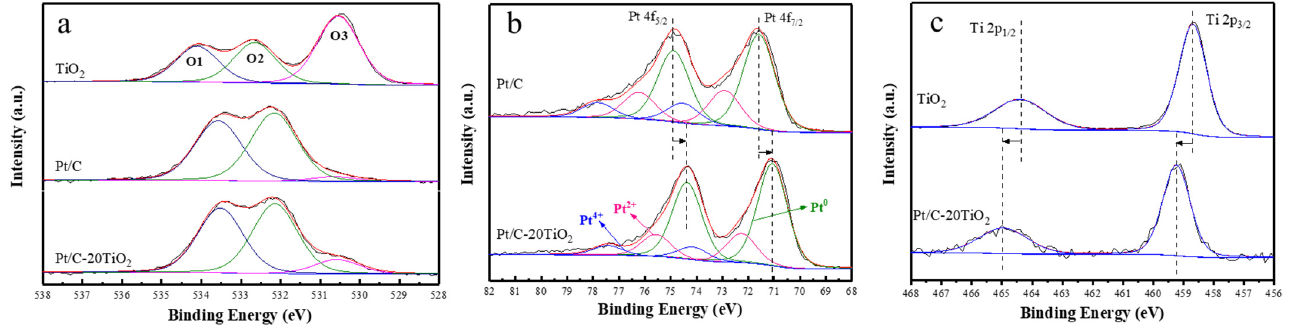
Figure 6. XPS spectra in ( a ) O 1s region of TiO 2 , Pt/C and Pt/C − 20TiO 2 ; ( b ) Ti 2p XPS of TiO 2 and Pt/C − 20TiO 2 ; ( c ) Pt 4f XPS of Pt/C and Pt/C − 20TiO 2 .